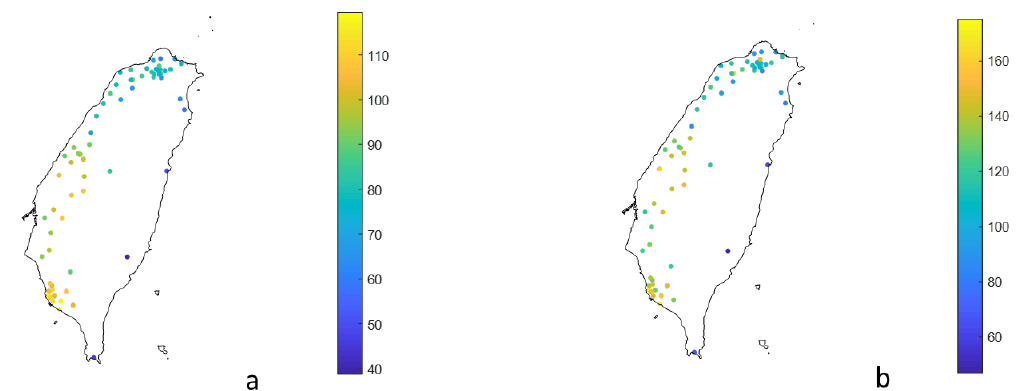
Figure 2. Average extreme PM 2.5 concentration within 96 h from 2005 to 2015 (unit: μg/m 3 ).